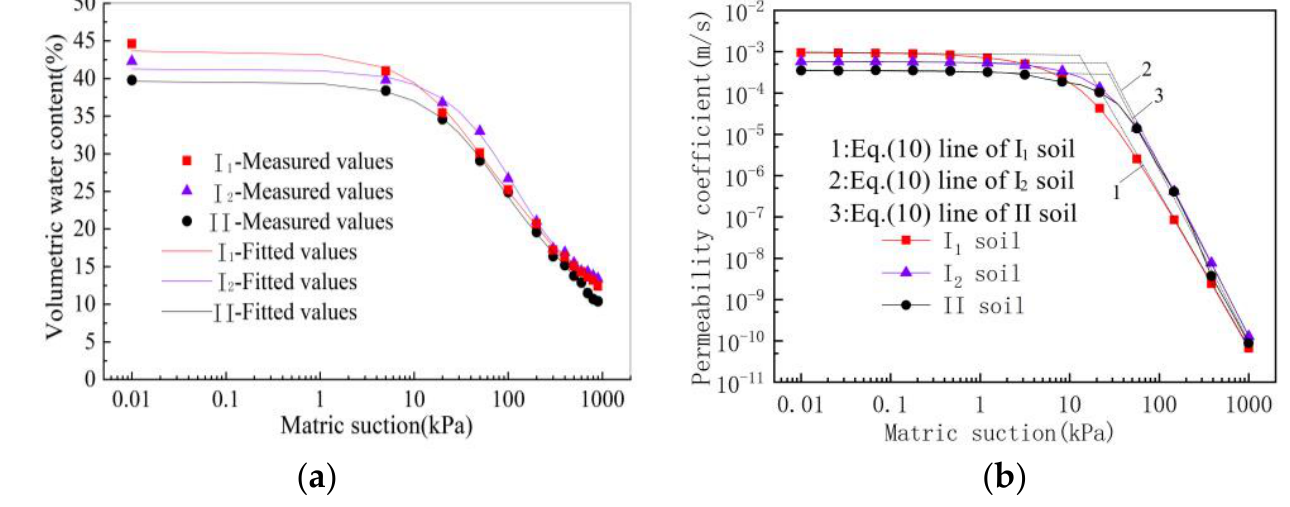
Figure 7. Relation curve of volumetric water content, matric suction and permeability coefficient. ( a ) Relation curve of volumetric water content and matric suction; ( b ) relation curve of volumetric permeability coefficient and matric suction.